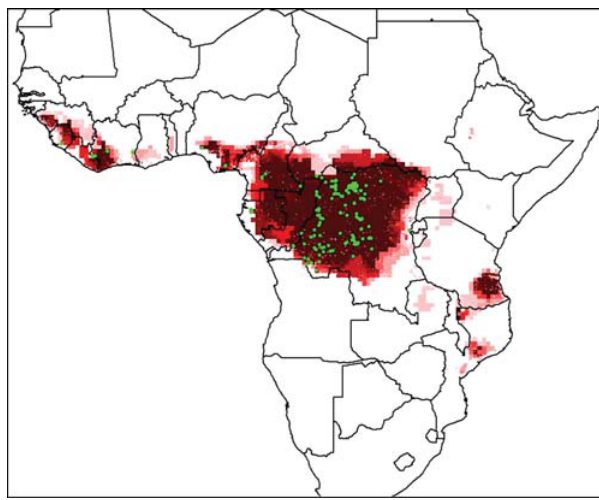
Figure 2. Overall predicted distribution of human monkeypox based on ecological niche modeling. Darker shades indicate areas with greater model agreement in prediction of suitability for monkeypox. Green points indicate input occurrences used in model